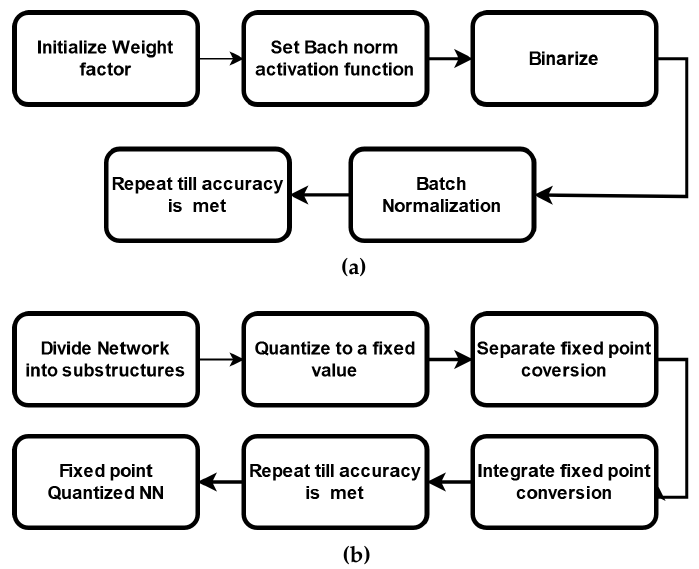
Figure 6. Block diagram of ( a ) BNN and ( b ) QNN for pattern